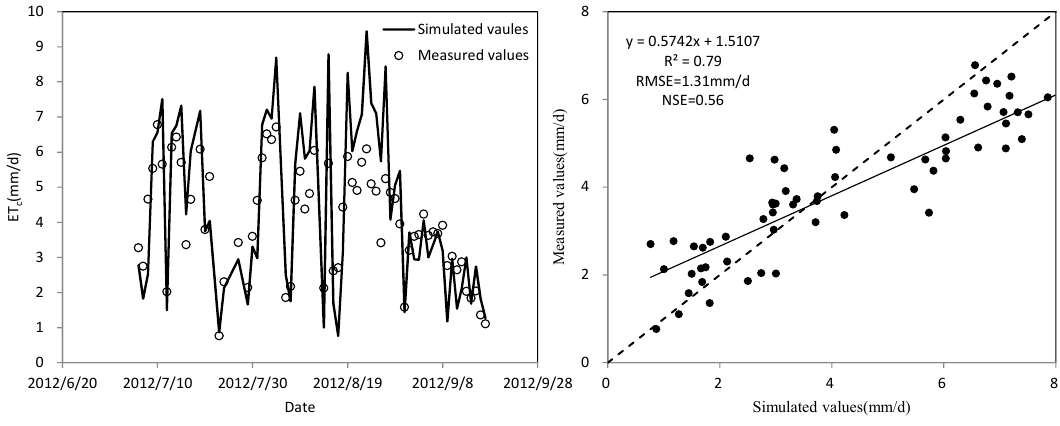
Figure 5. Comparison between the simulated and observed ET c values of maize for seed.